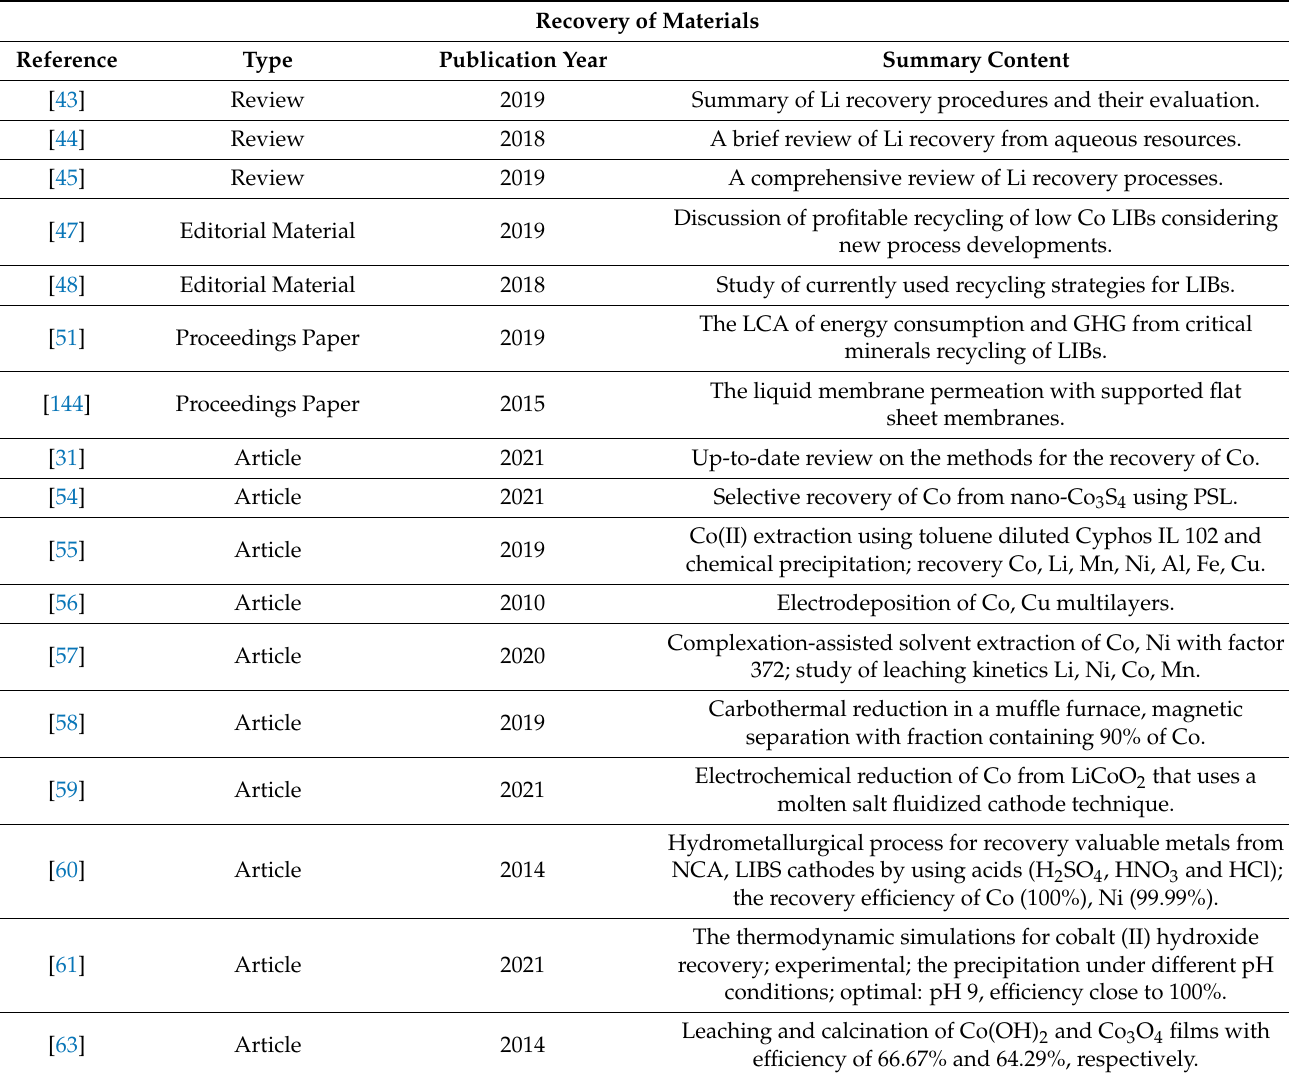
Table A4. Assessed literature in review for “Recovery of Materials”